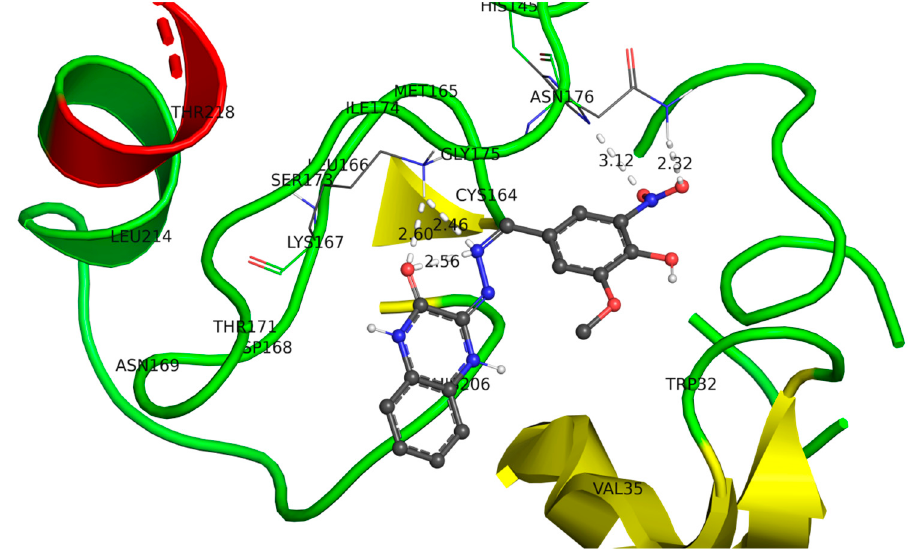
Figure 6. Docking pose of molecule ( 4c ) in the active site of metallo- β -lactamase pdb: